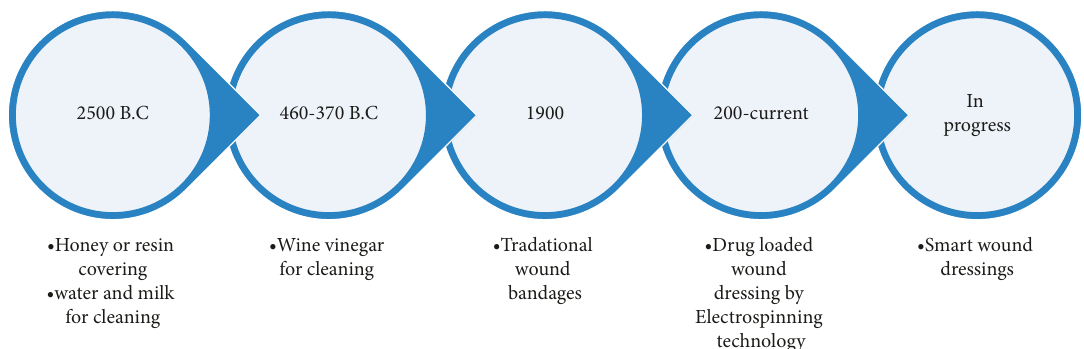
Figure 2: The stages of wound dressing in the